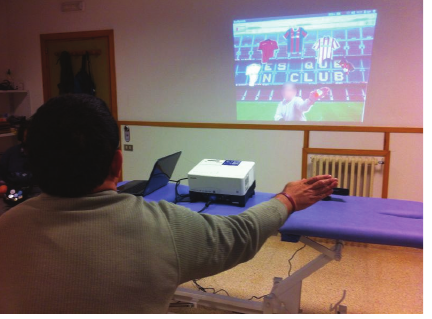
Figure 5: Real performance of the system in ASPACE rehabilitation room using mirror feedback.